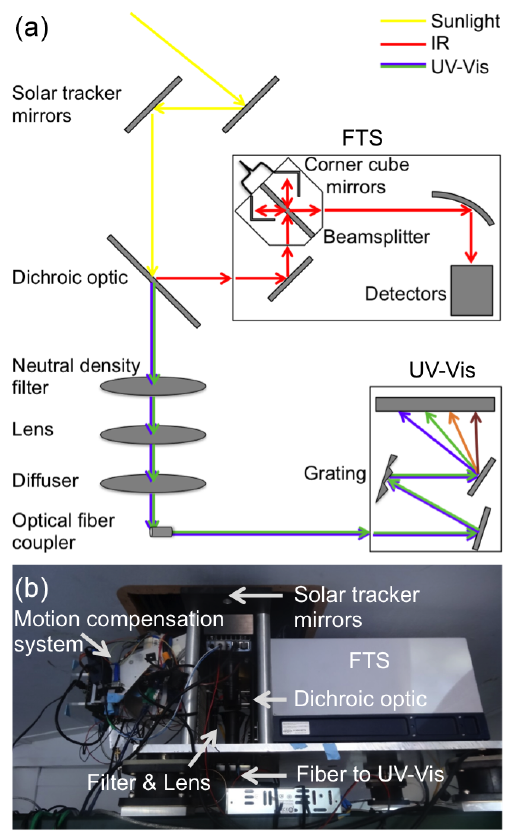
Figure 1. (a) Conceptual sketch of the mobile SOF instrument com- ponents. (b) Picture of the instrument installed inside the trailer.